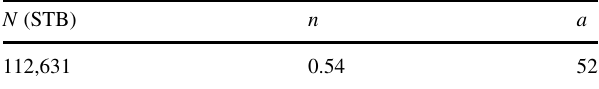
Table 3 Summary of logistic growth model parameters obtained for a well in the dataset N (STB)